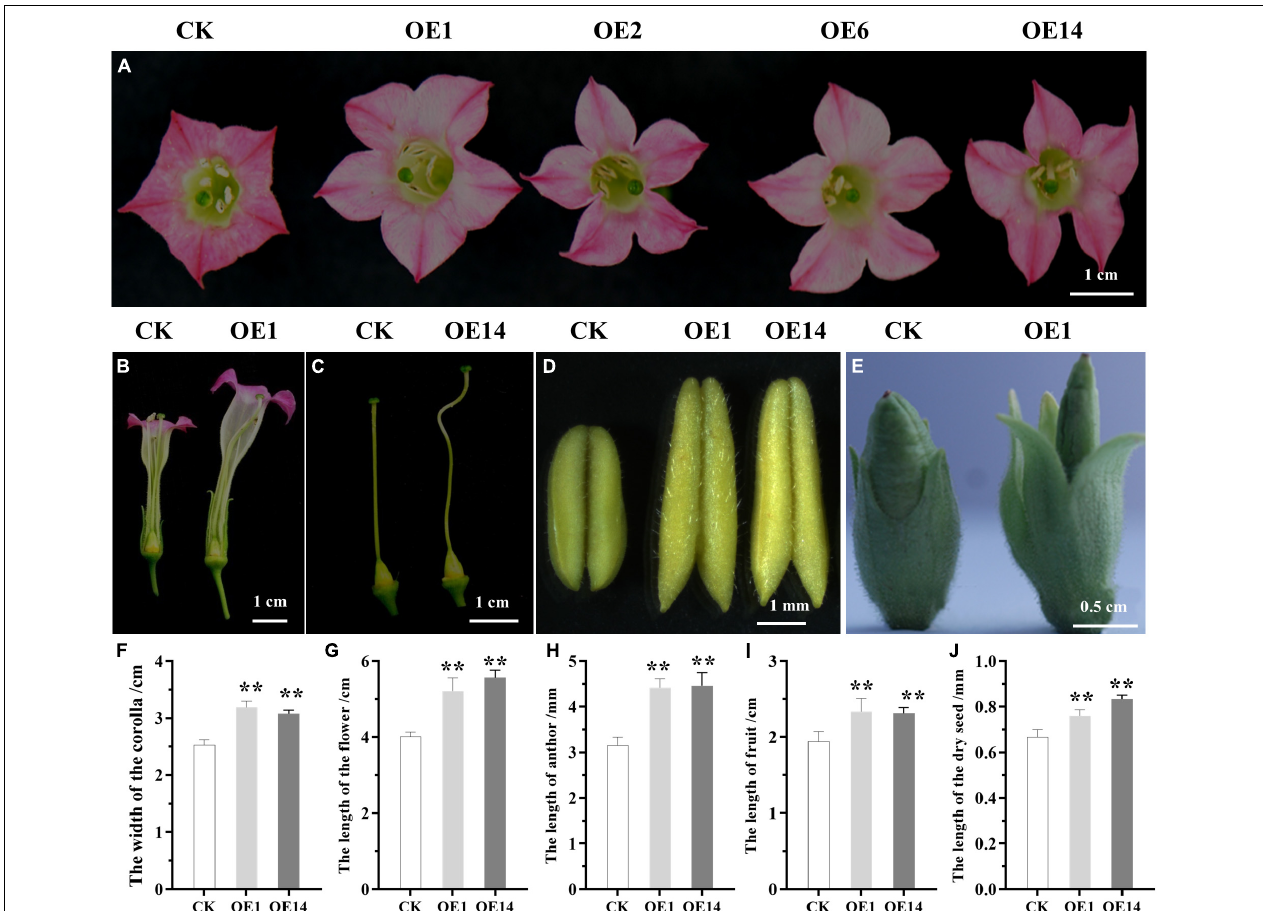
FIGURE 4 | The differences in reproductive organs between CK and transgenic tobacco. (A) Comparison of the morphology of corollas; (B) longitudinal cutting of floral organs flowers; (C) comparison of the morphology of pistils; (D) comparison of the size of anthers; (E) comparison of the morphology of fruits; (F–J) statistical analysis of the phenotype of corolla, flower, anther, fruit, and dry seed. CK, empty vector control; OE1/2/6/14, four individual transgenic lines. Asterisks on the column diagram showed the significant difference between different samples ( p ≤ 0.01).